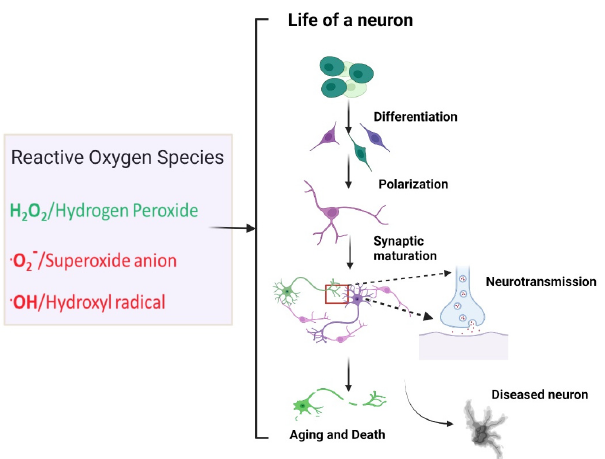
Figure 1. Influence of reactive oxygen species in the life of a neuron. Under normal conditions, the diffusible nonradical ROS, hydrogen peroxide, is synthesized physiologically and is a key regulator of processes fundamental to neuronal development and function, including neuronal differentiation, polarization, synaptic maturation, neuropeptide secretion, and neurotransmitter receptor transport. On the other hand, uncontrolled ROS production by damaged mitochondria, especially of superoxide and hydroxyl radicals, are potentially detrimental. Uncontrolled ROS may damage neurons, promote neuronal decline, and exacerbate neurodegenerative pathology. Created with BioRender.com (accessed on 17 February 2022).